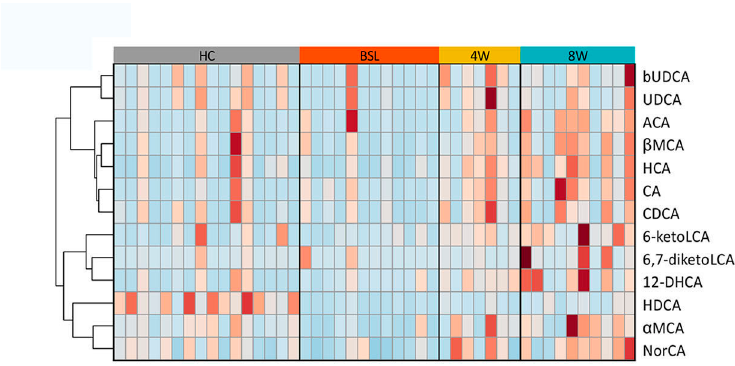
Figure 7. Significantly changed BAs in CD patients after EEN therapy. Heatmap demonstrating significantly changed BAs (all upregulated) in CD patients after EEN induction therapy with fold changes > 2.0. Statistical significance was determined using two-tailed Mann–Whitney U-tests, with FDR < 0.05 and fold difference > 2.0. bUDCA, 3 β -ursodeoxycholic acid; UDCA, ursodeoxycholic acid; ACA, allocholic acid; β MCA, β -muricholic acid; HCA, hyocholic acid; CA, cholic acid; CDCA, chenodeoxycholic acid; 6-ketoLCA, 6-ketolithocholic acid; 6,7-diketoLCA, 6,7-diketolithocholic acid; 12-DHCA, 12-dehydrocholic acid; HDCA, α -hyodeoxycholic acid; aMCA, α -muricholic acid; NorCA, norcholic